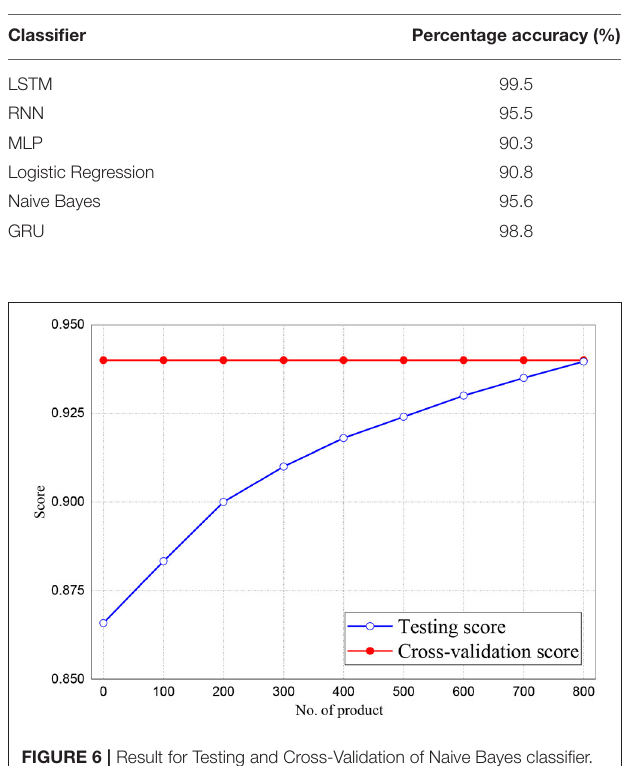
TABLE 5 | Performance of testing score accuracy for selected classifiers.